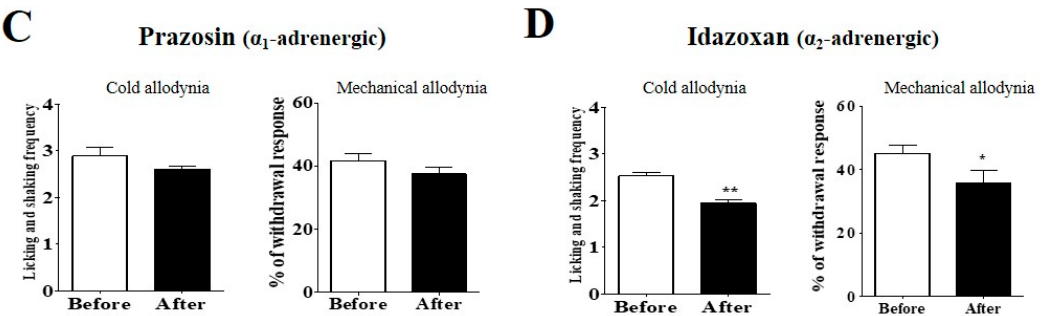
Figure 3. Effect of α -adrenergic receptor antagonists on the analgesic effect of duloxetine on cold and mechanical allodynia in mice. The behavioral tests for cold and mechanical allodynia measurements were performed 20 min prior to the pre-treatment of antagonist (Before) and 60 min after the intraperitoneal injection of 30 mg/kg of duloxetine (After). Phentolamine (non-selective α -adrenergic receptor antagonist, 20 μ g, n = 7), prazosin ( α 1 -adrenergic receptor antagonist, 10 μ g, n = 6), and idazoxan ( α 2 -adrenergic receptors, 10 μ g, n = 6) were administered intrathecally ( B – D , respectively). D.W. ( n = 6) was injected to the control group ( A ). Data is presented as the mean ± S.E.M.; * p < 0.05, ** p < 0.01, *** p < 0.001 vs. Before; by paired t -test.